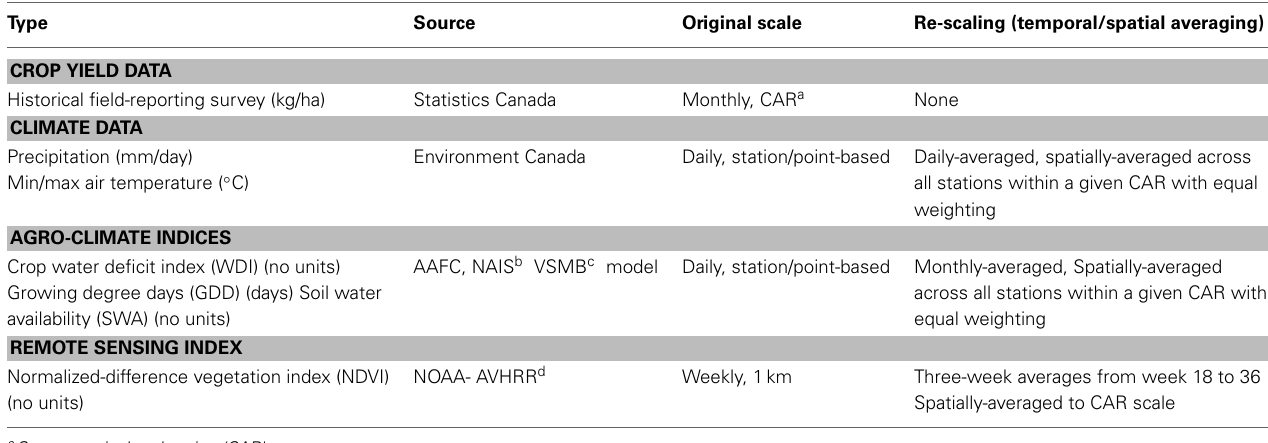
Table 1 | Data integrated for simulating, training and validating the forecasting model across